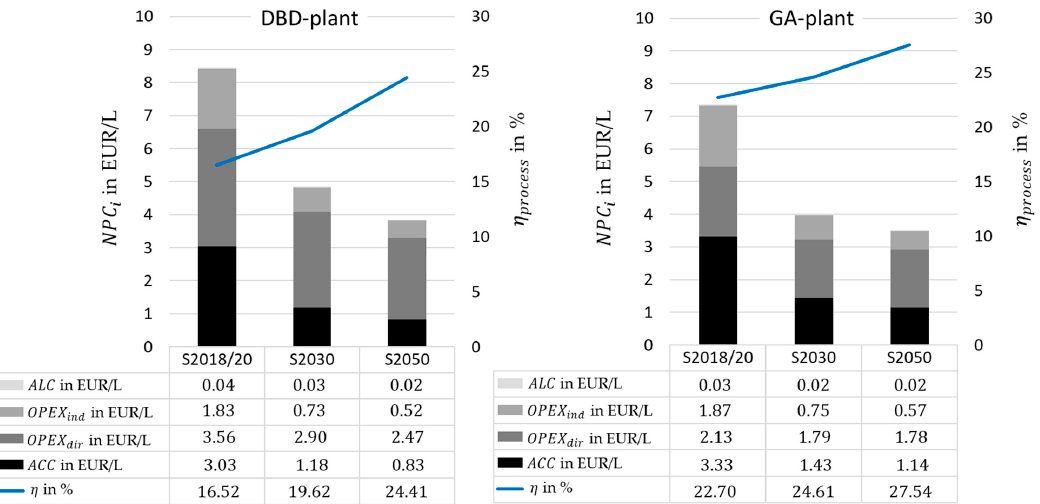
Figure 10. Net production costs (NPC) of scenarios for dielectric barrier discharge (DBD)-plant and gliding arc (GA)-plant.